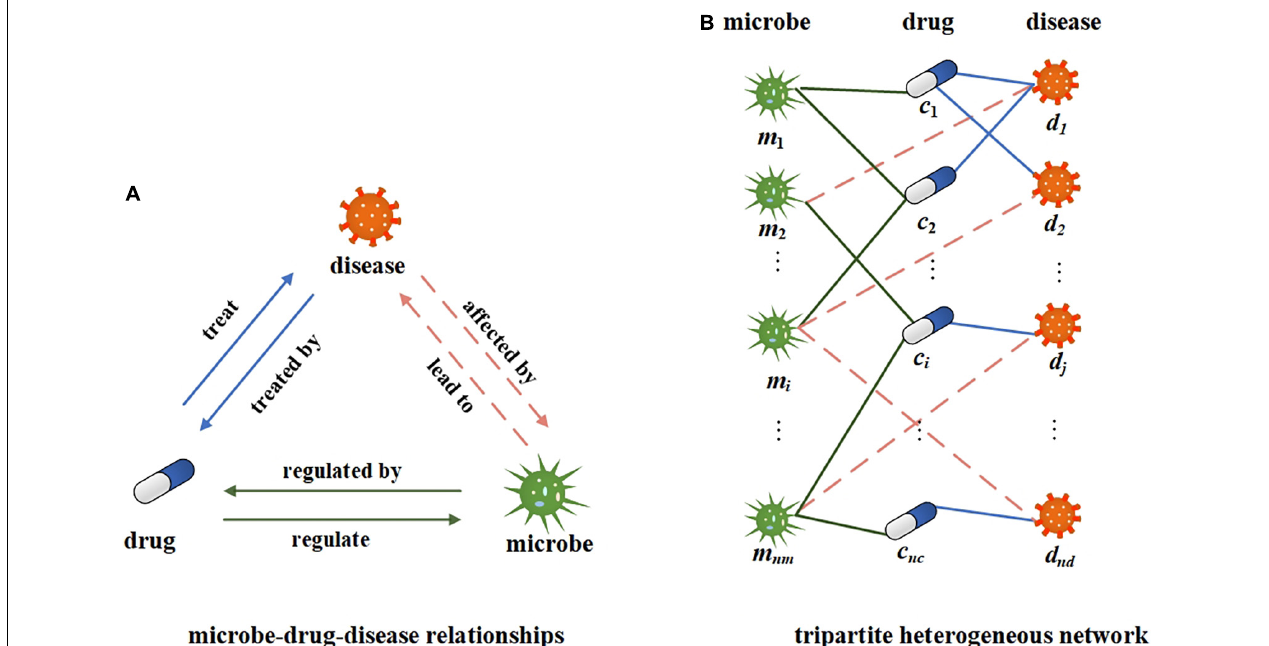
FIGURE 2 | Illustration of microbe-drug-disease relationship and heterogeneous networks. (A) The illustration of microbe-drug-diease relationships. (B) A tripartite network corresponding to the microbe-drug-disease relationships.